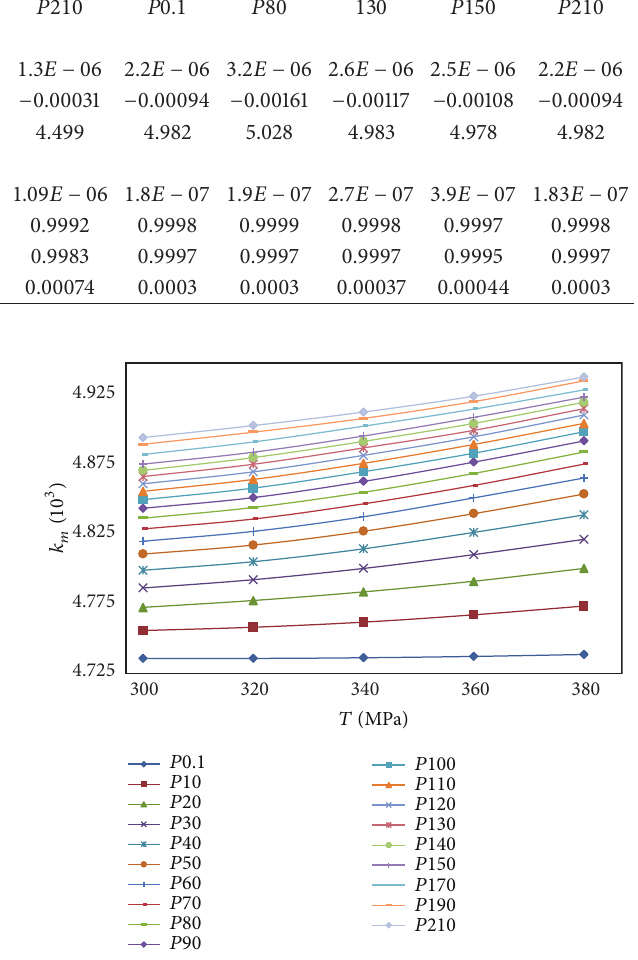
Figure 4: Molecular compressibility of ethyl caprate (EeC10:0) as a function of temperature along various isobaric (only calculated values were